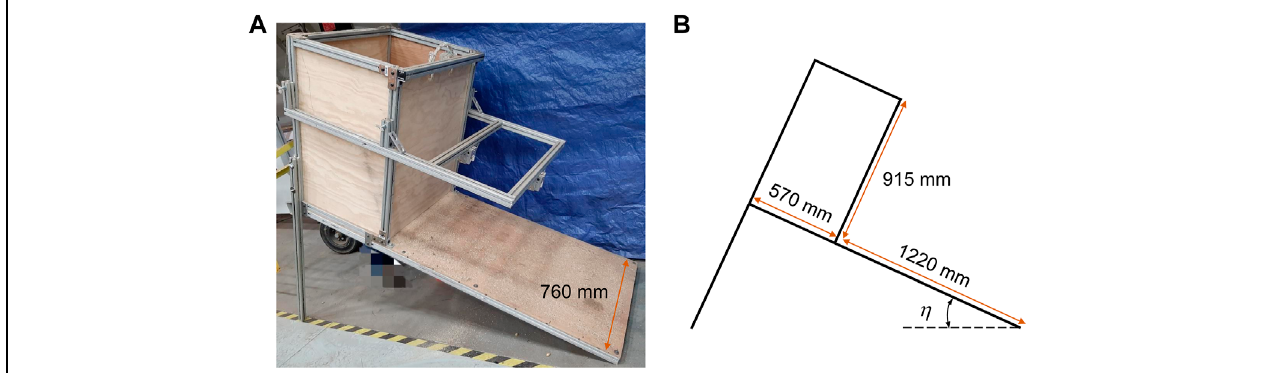
Frontiers in Energy Research |